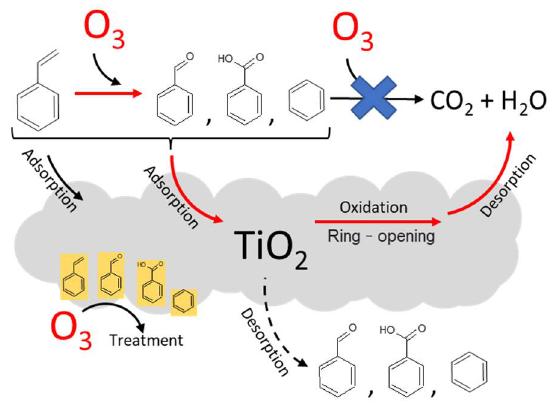
Figure 9. Proposed mechanisms of the decomposition of styrene using photocatalyst and ozone treatment.